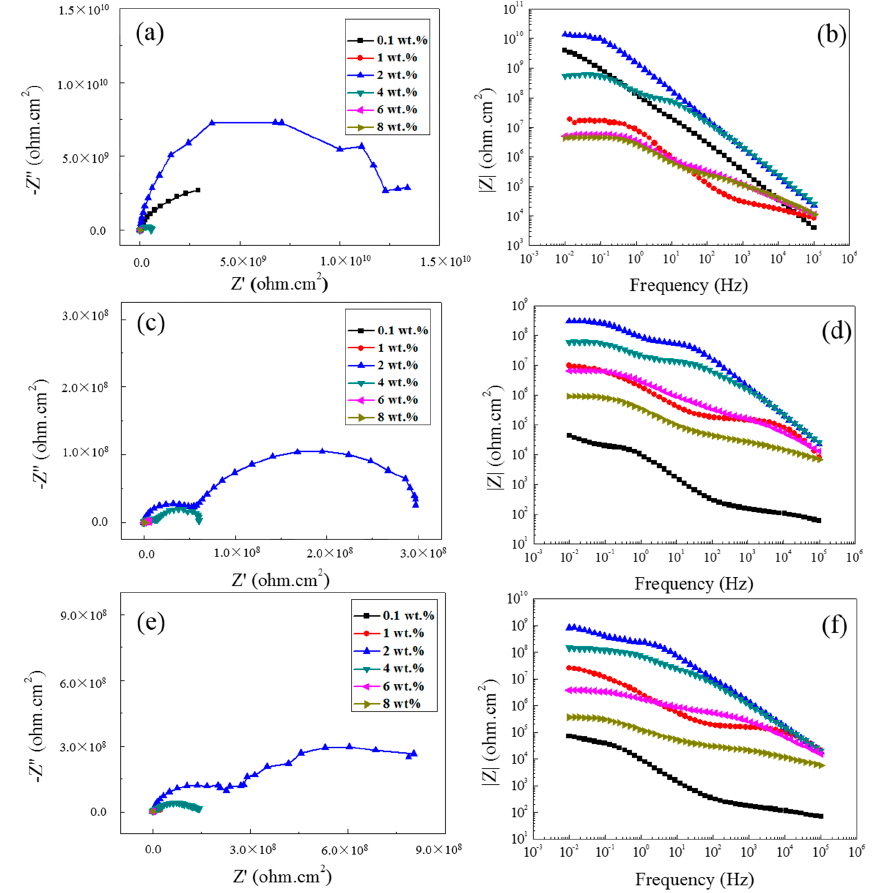
Figure 3. Nyquist plots of the coatings with different content of PANI-SSA after different immersion time in 3.5% NaCl solution: ( a ) 1 h; ( c ) 1 d; ( e ) 5 d and the corresponding Bode plots: ( b ) 1 h; ( d ) 1 d; ( f ) 5 d.